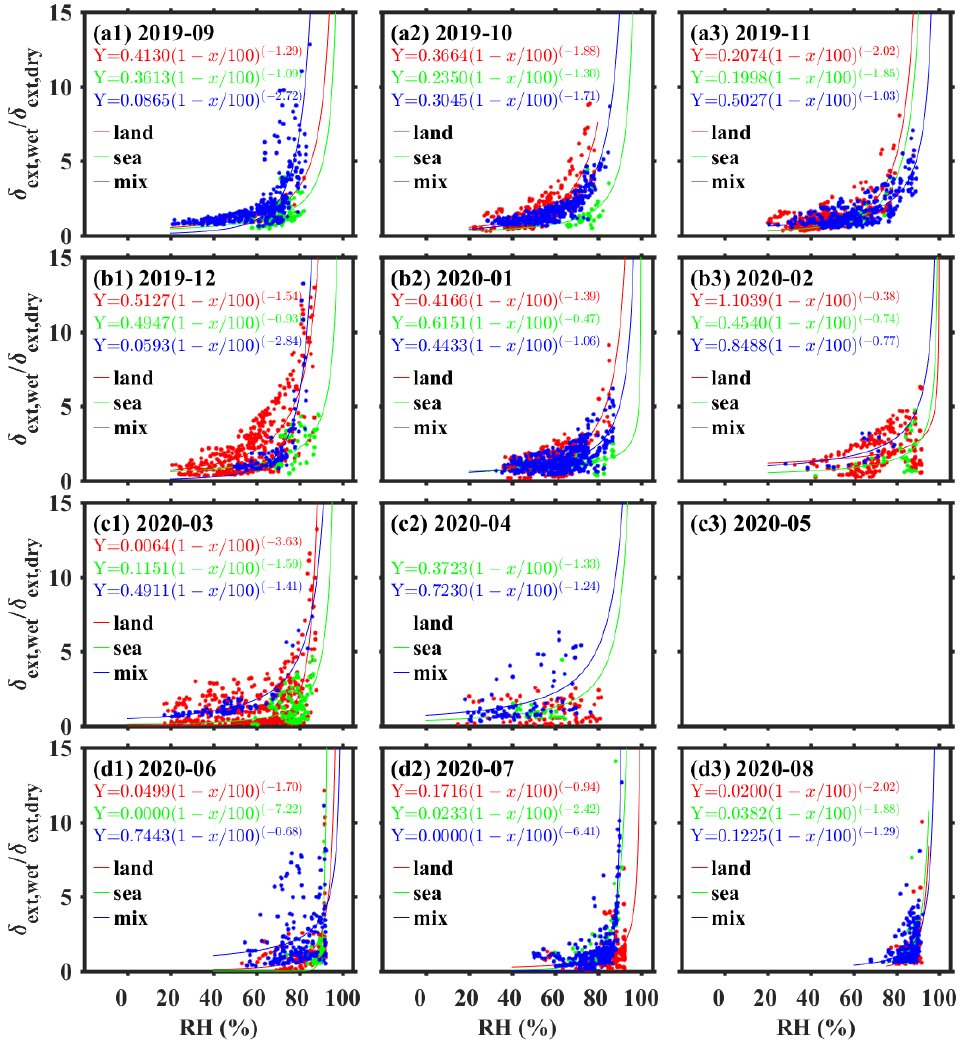
Figure 8. Monthly HGF ext of aerosol from different source in Qingdao from September 2019 to